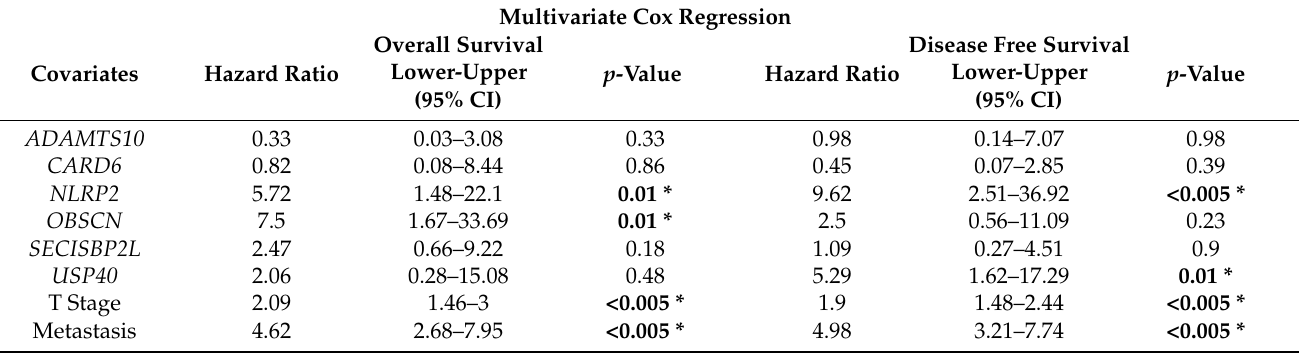
Figure 3. Survival analysis of the TCGA-KIRC data for all six survival genes ( ADAMTS10 , CARD6 , NLRP2 , OBSCN , SECISBP2L , and USP40 ). Overall survival (left) and disease-free survival (right) graphs based on data from ( a ) the Firehose Legacy and ( b ) the PanCancer Atlas. The hazard ratios (HR) and p -values from the multivariate Cox regression analysis of six survival-specific genes and two clinical factors, T stage and metastasis, are shown in Table 7. Mutations in NLRP2 and OBSCN were significant in OS (HR = 5.72, p = 0.01 and HR = 7.5, p = 0.01), whereas NLRP2 and USP40 genes were significant in DFS (HR = 9.62 and p = <0.005 and HR = 5.29, p = 0.01). Additionally, it was noticed that mutations in NLRP2 and OBSCN showed a statistically significant co-occurrence tendency ( p = 0.042; Log2 Odds Ratio >3) from the Mutual Exclusivity analysis by cBioPortal (Zhiping Gu (2016), “cBioPortal,” https://ncihub.org/resources/1624, accessed on 15 November 2021). We identified that NLRP2 gene mutations are significant in both OS and DFS. In Figure 4, NLRP2 and OBSCN gene mutations have a higher risk ratio in OS than the two clinical factors. Similarly, NLRP2 and USP40 mutations have a higher risk ratio in DFS than both clinical factors. Table 7. Multivariate Cox regression analysis on survival in six survival-specific genes from TCGA- KIRC (Firehose Legacy)